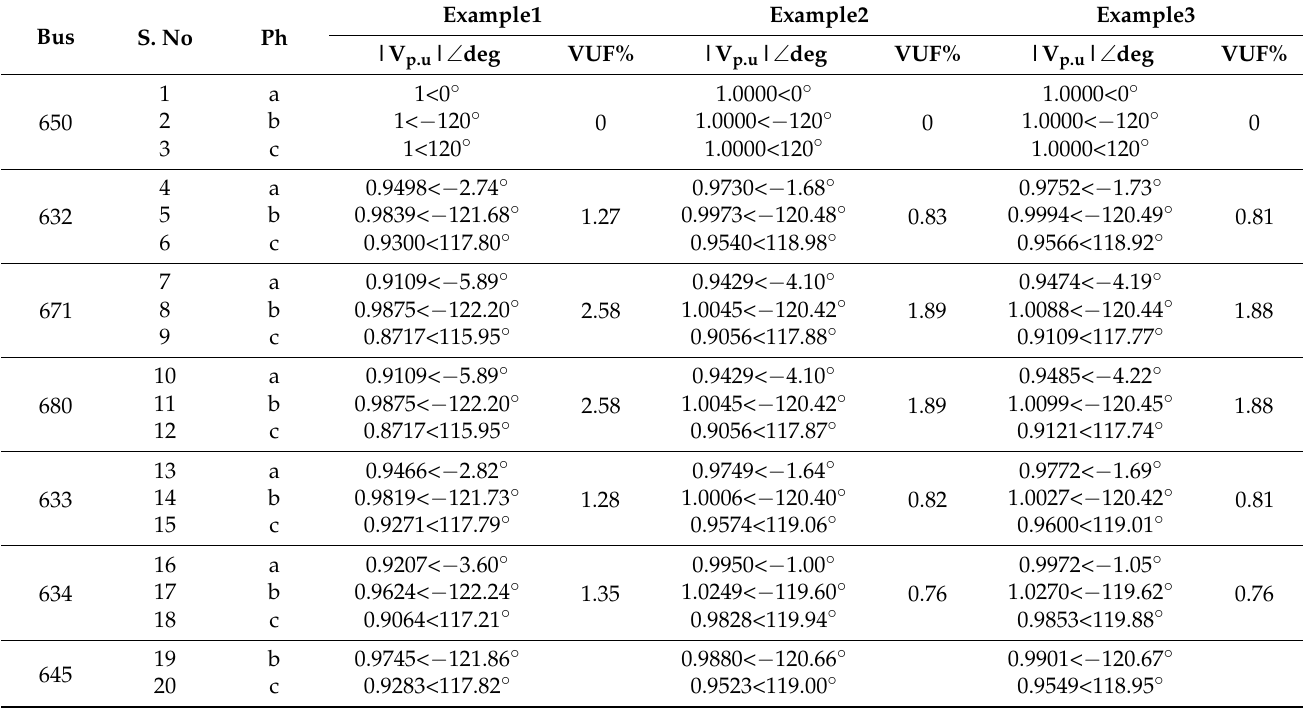
Table 8. Obtained voltage solution and VUF% for different study examples of the IEEE-13 bus URDN.